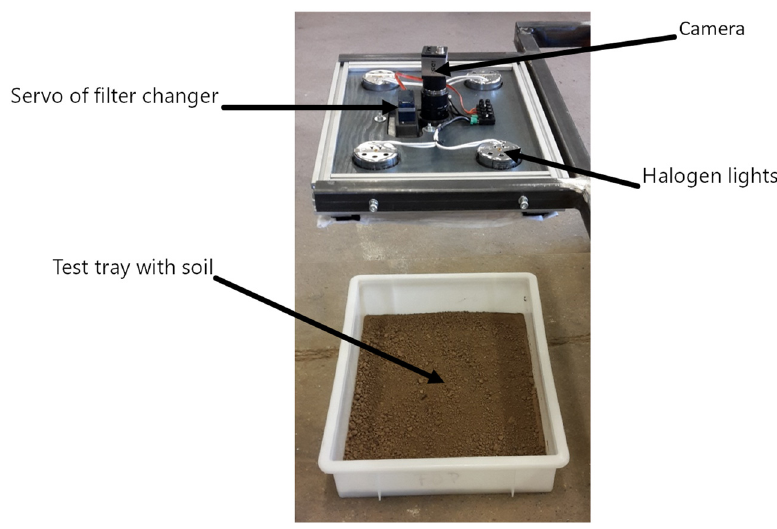
Figure 3. The developed set up of the detection